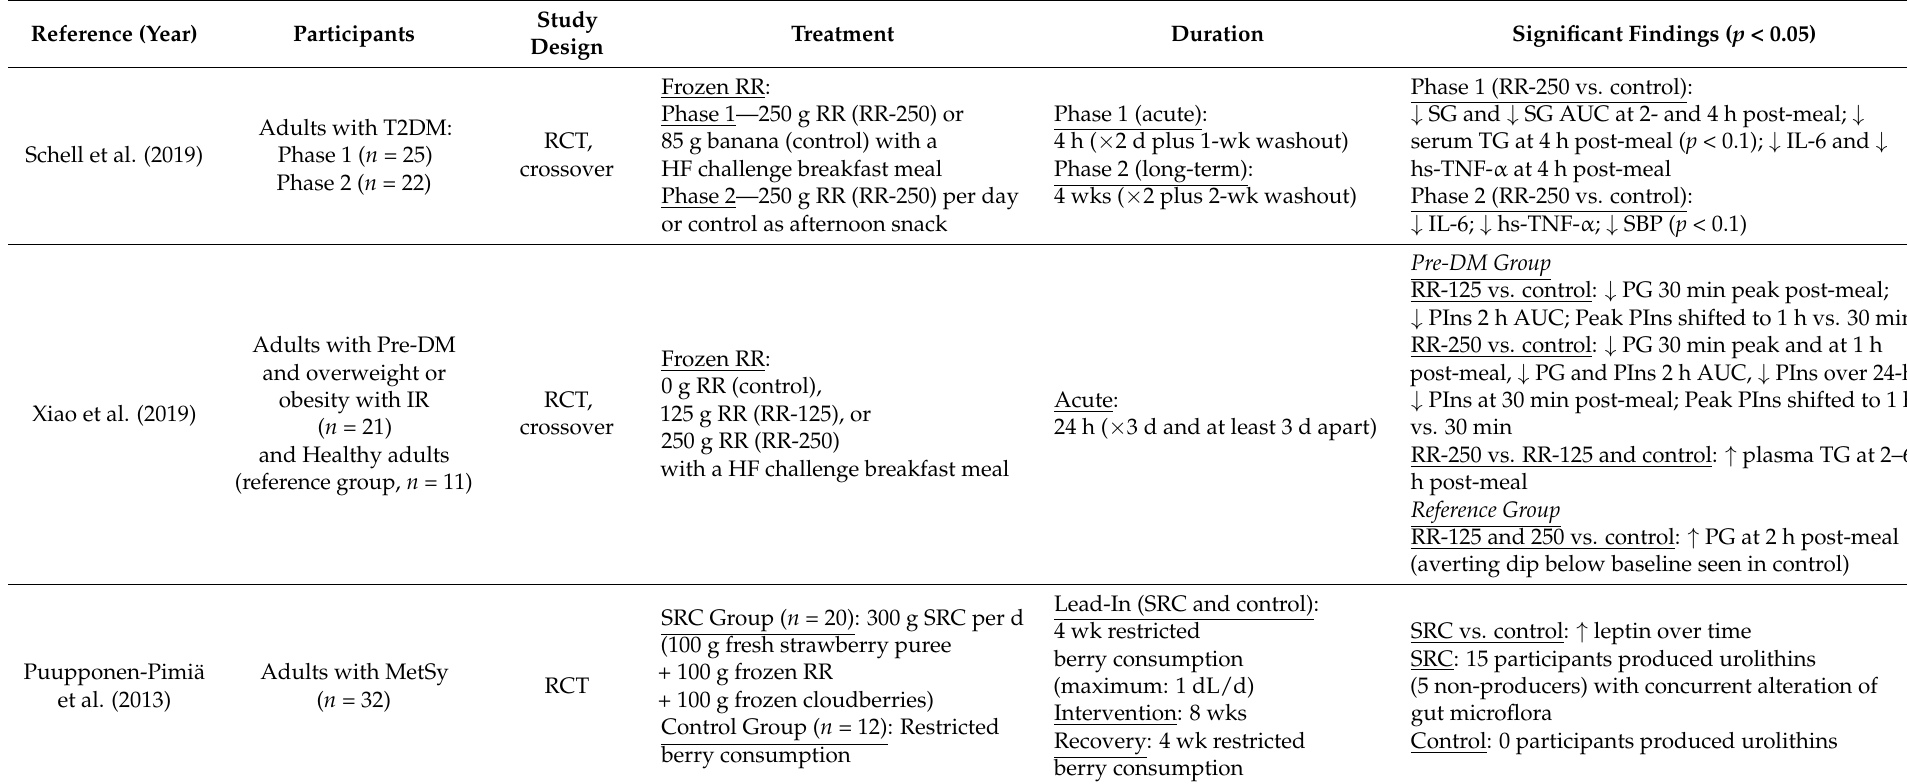
Table 1. Summary of randomized controlled trials investigating the effects of dietary whole red raspberries in humans with metabolic